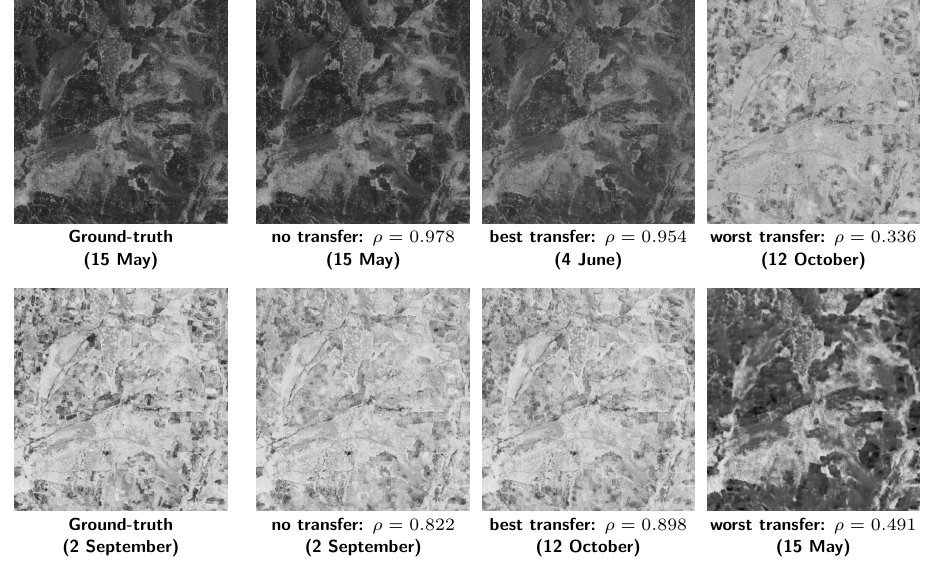
Figure 7. Temporal transfer learning tested on 15 May ( top ) and 2 September ( bottom ). From left to right is the target F followed by estimates provided by the model optical-SAR+ trained on the target date (no transfer) and on two alternative dates (best and worst